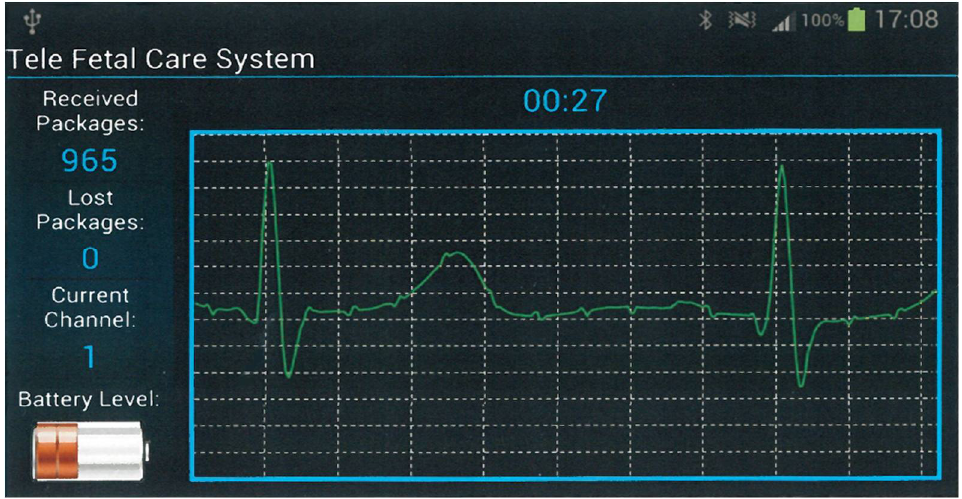
Figure 8. A snaphot of the mobile device while it is capturing a plain ECG.